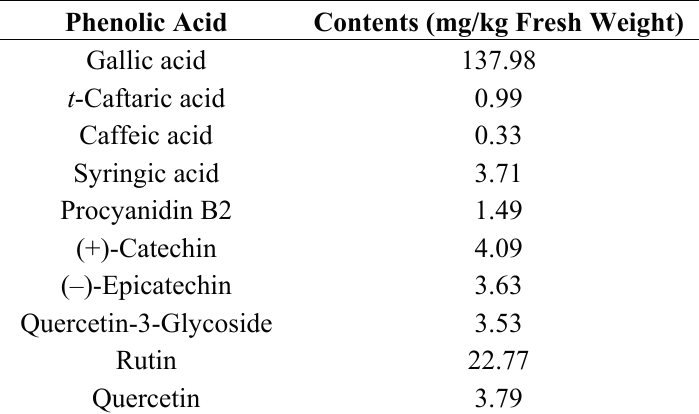
Table 9. Phenolic acids profile of blackberry fruit